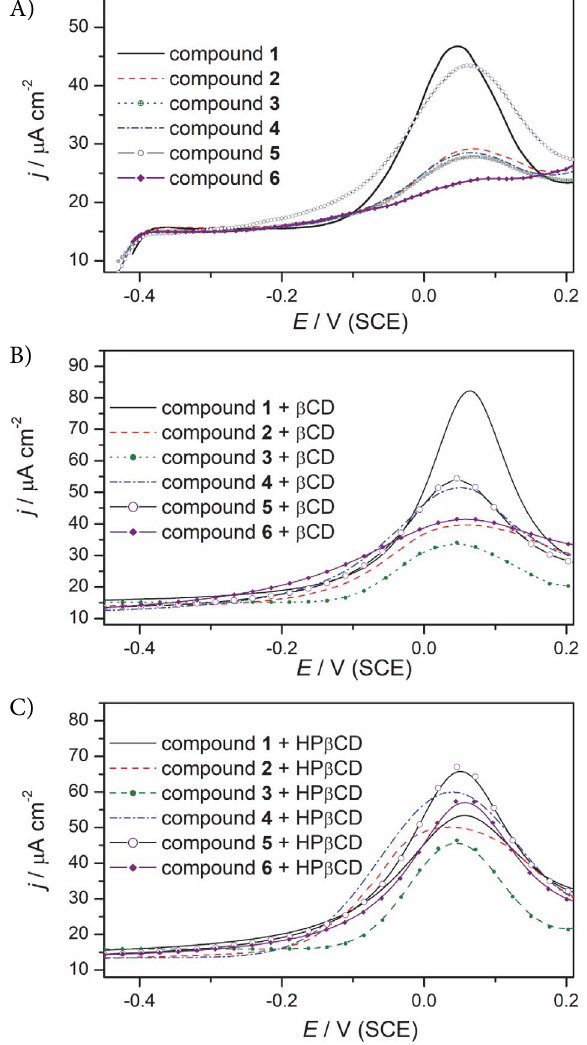
Figure 5. SWVs of investigated compounds (A); of the inclusion complexes of the investigated compounds with βCD (1:1) (B) and of the inclusion complexes of the investigated compounds with HPβCD (1:1) (C), obtained on Au electrode using 0.05 M NaHCO 3 . Accumulation time: 0.2 s at E = – 0.45 V; step size 5 mV, pulse size 75 mV, frequency 10 Hz, scan rate 50 mV s –1 .